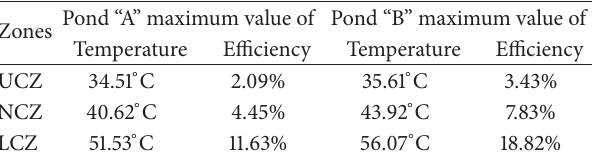
Table 4: Performance of convective zones of both the models “A” and “B”.